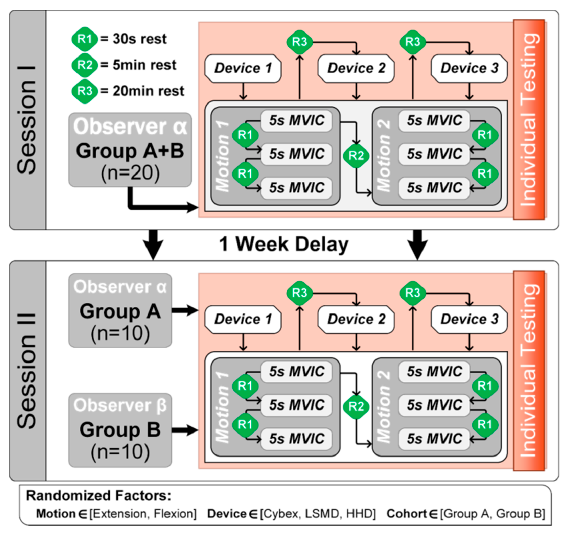
Figure 3. Flow chart of the experimental design.